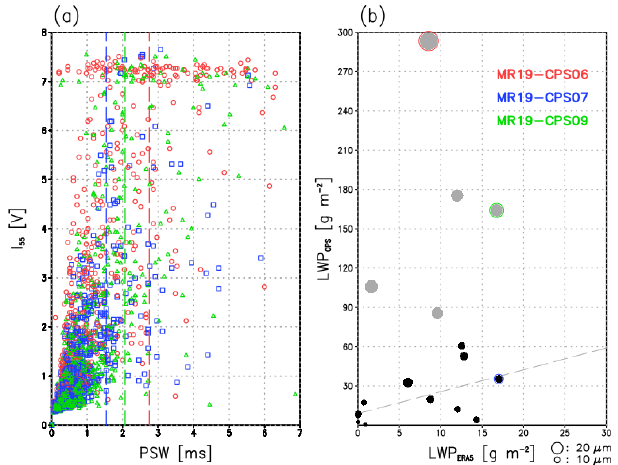
Figure 6. (a) Relationships between PSW (ms) and I 55 (V) for MR19-CPS06 (red), MR19-CPS07 (blue), and MR19-CPS09 (green), and (b) scatter plot of LWP (gm − 2 ) from ERA5 and CPS sonde for the cruises in 2018 and 2019. Colored dashed lines in panel (a) show the cutoff PSW (PSW c ). Dots in panel (b) indicate the relative size of the mean effective radius ( r e ). Gray dots show the cases with r e larger than 20µm. A gray dashed line indicates a linear regression line by excluding the cases with r e larger than